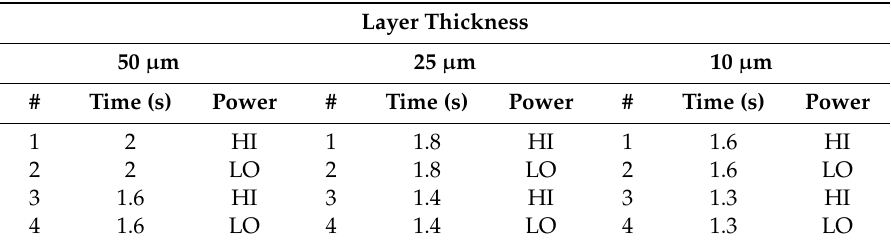
Table 1. Values of the process parameters for three designed experiments. Layer Thickness 50 µ m 25 µ m 10 µ